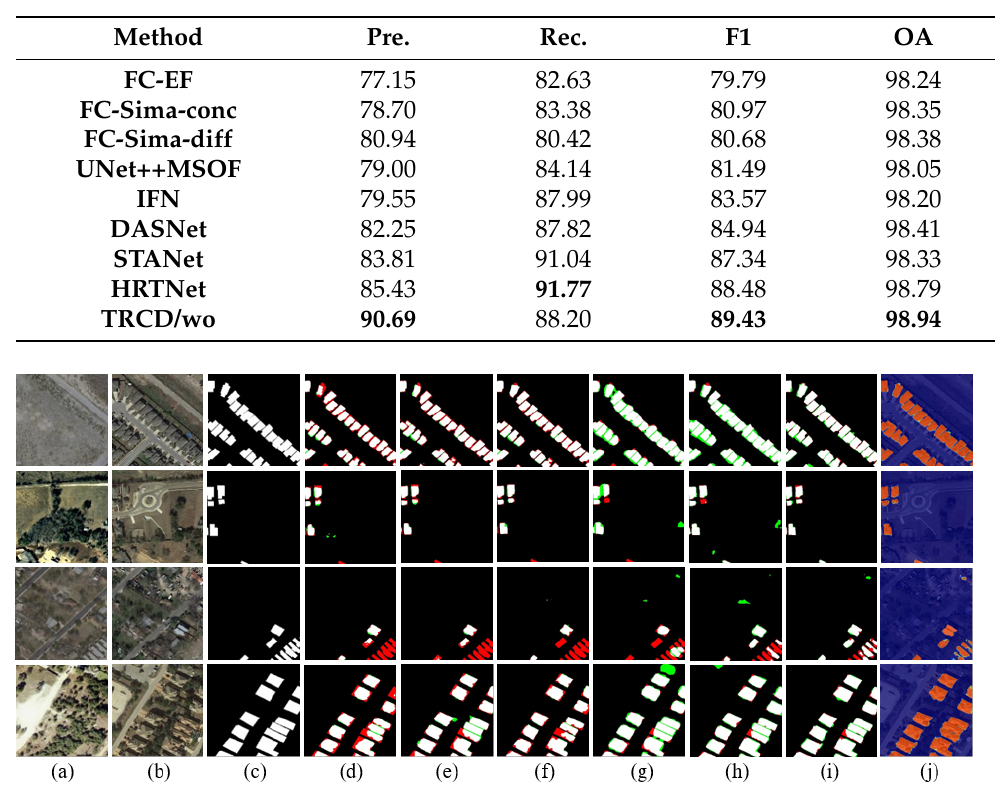
Table 3. Evaluation results of TRCD and other advanced algorithms on LEVIR-CD with 2048 pairs of images.